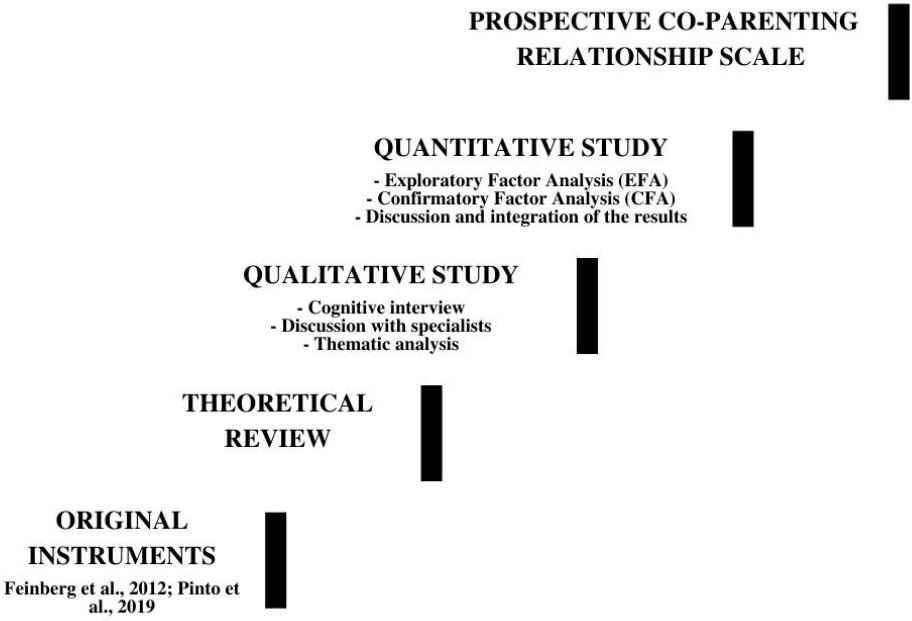
Figure 1. Procedure used to adapt and validate the Prospective Co-Parenting Relationship